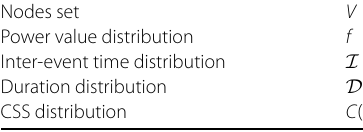
Table 2 Overview of the parameters used in the proposed model Nodes